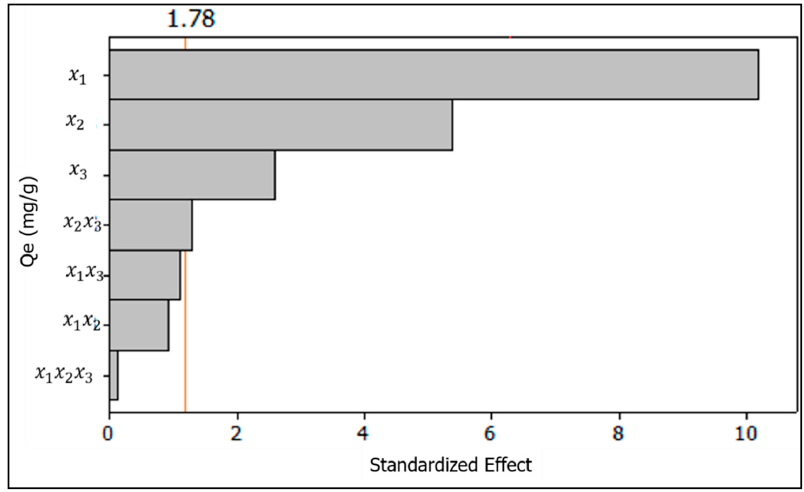
Figure 6. Pareto chart ( t ‐ test) for the desorption of MB from the clay adsorbent coating.